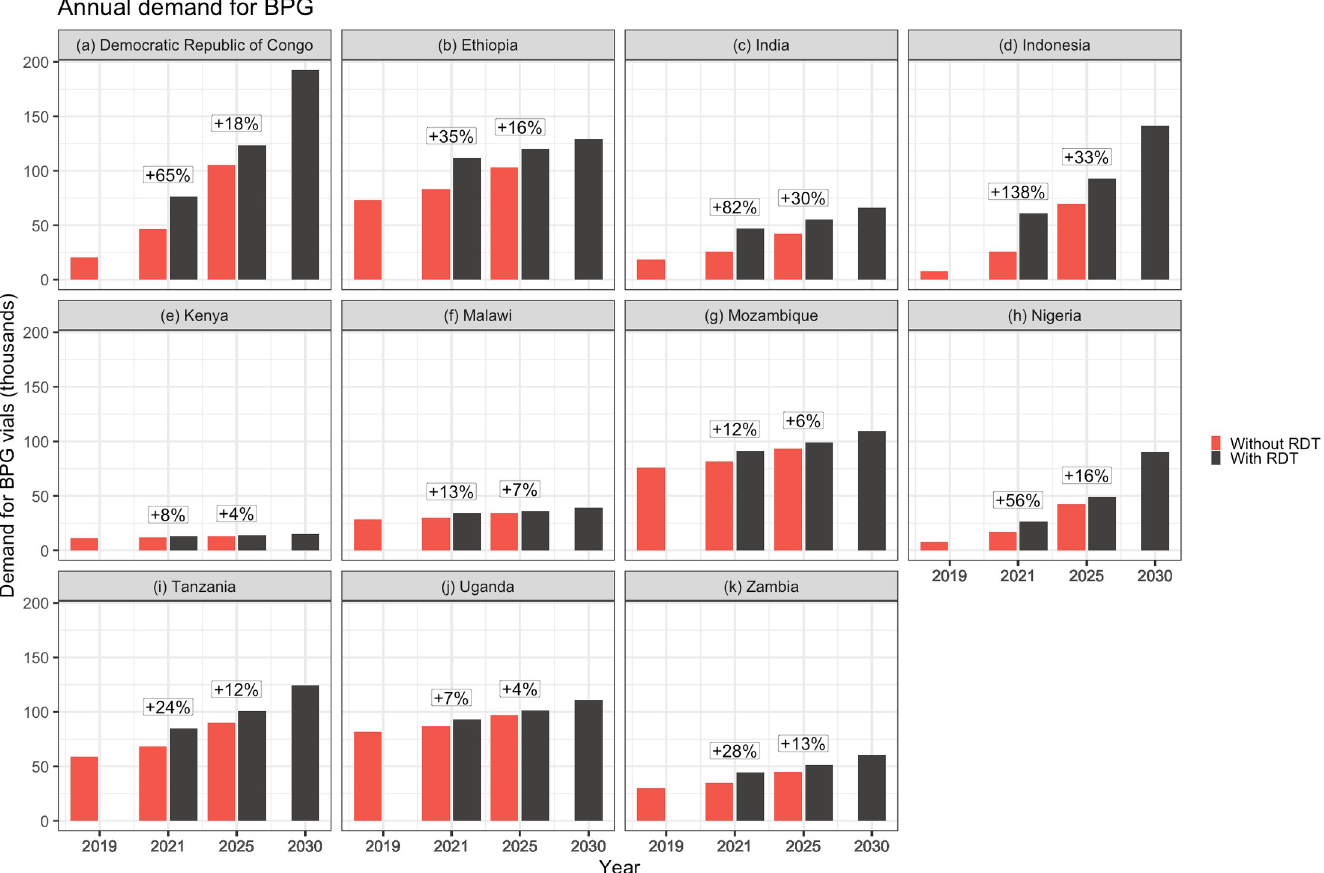
Fig 1. Increase in demand of BPG for treating syphilis positive PW in 11 focus countries. Graph indicates the quantity of 2.4 MU BPG vials required for treatment of PW identified syphilis positive with or without dual HIV/syphilis RDT if dual tests replace all syphilis testing in 2021.